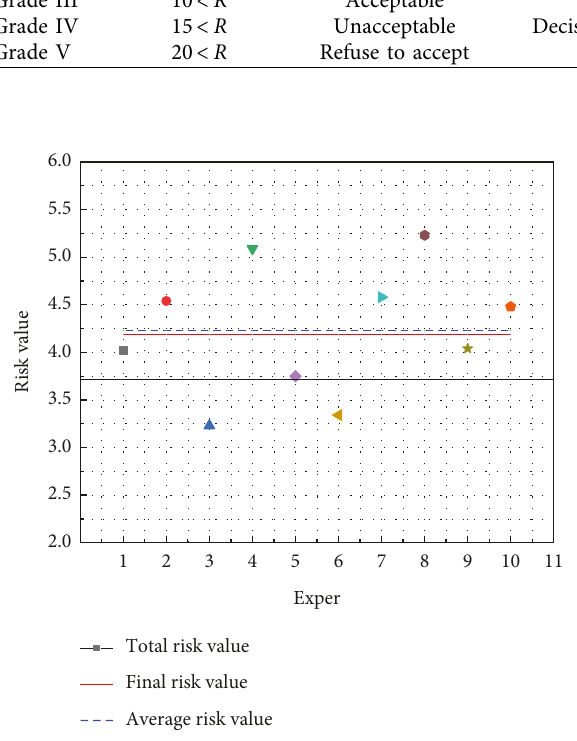
Figure 14: Total risk value of each expert.